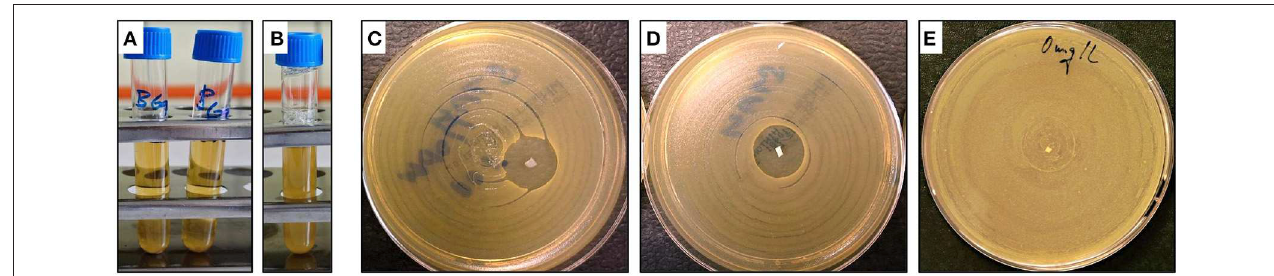
FIGURE 9 | Photographs showing the main results of antibacterial activity tests: (A,B) tube tests and (C–E) disk diffusion tests. Pictures of tubes (A,B) were made after 18h of incubation: (A) shows translucent solutions of TPS/ATB (right) and TPS/TiO 2 /ATB (left), while (B) shows turbid solution of control neat TPS sample. Pictures of disks (C–E) display clear inhibitory zones around small white rectangular samples of TPS/ATB (C) and TPS/ATB/TiO 2 (D) , while the control neat TPS sample exhibits no inhibitory zone (E)